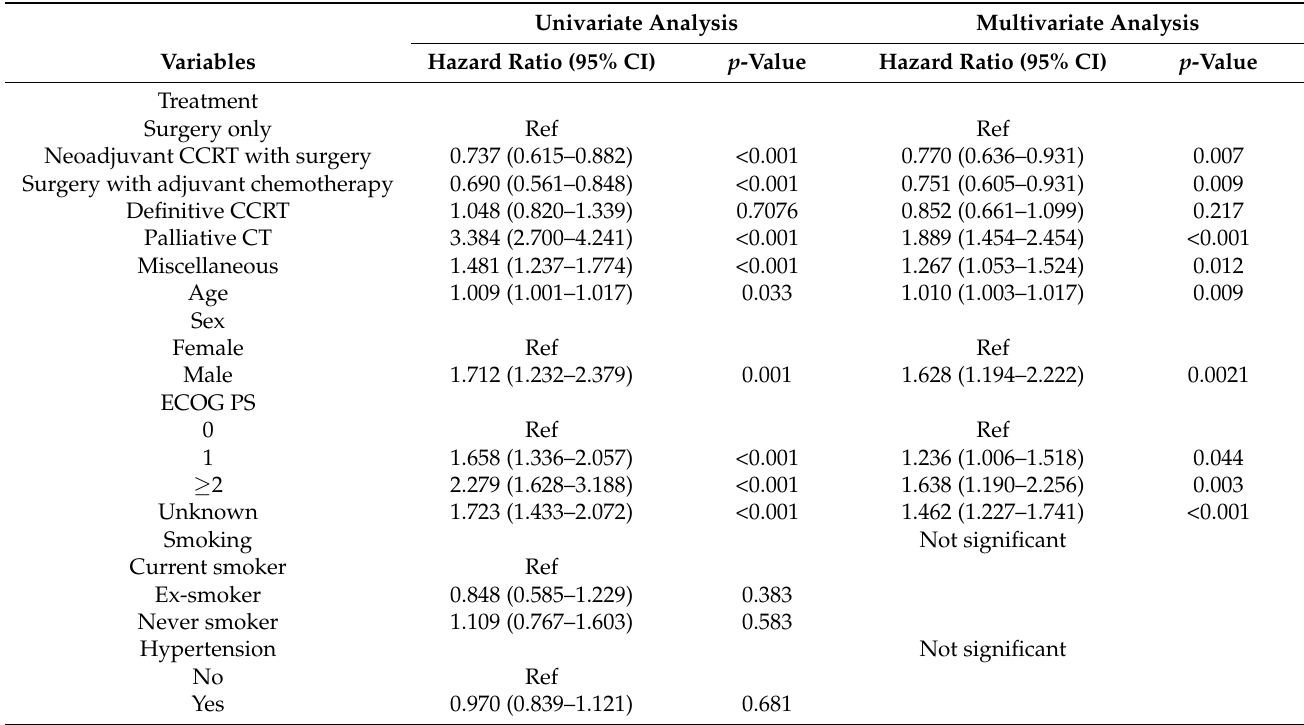
Table 3. Hazard ratio estimated in univariate and multivariate Cox proportional-hazard models. Univariate Analysis Multivariate